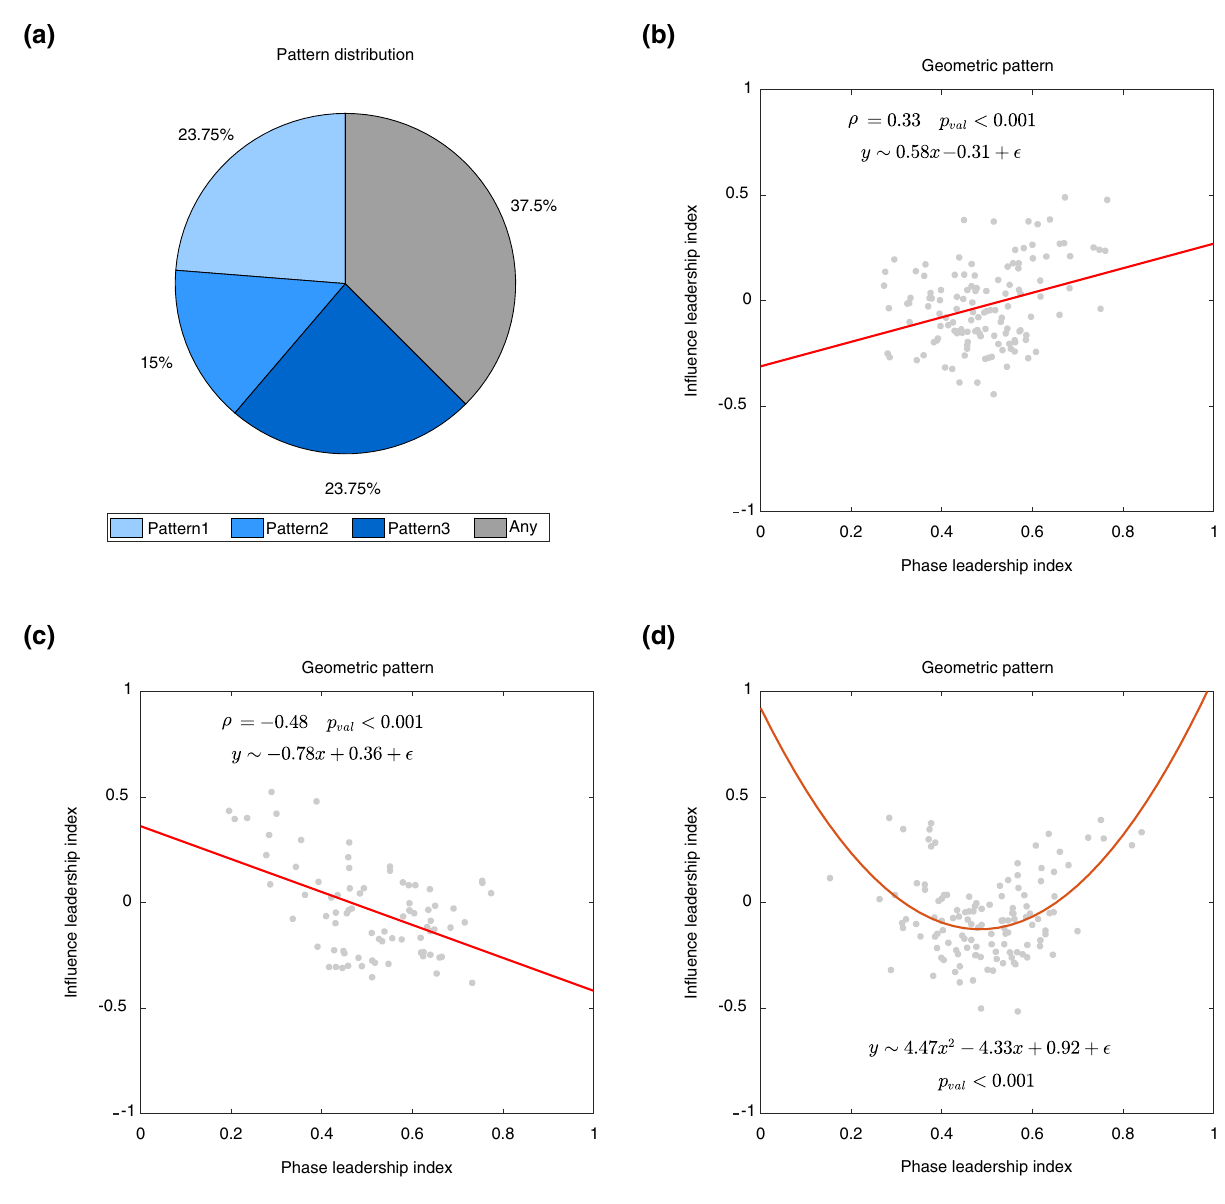
Figure 3. Distribution and characterization of the leadership scenarios. ( a ) The pie chart depicts how the three patterns were distributed among the trials of Experiment 1. A correlation analysis between the net information flow NetCaus and the mean position ranking H in the trials where Pattern 1 and 2 were observed is reported in ( b ) and ( c ), respectively. The linear fitting is represented by a red solid line. In Pattern 3, the relationship between NetCaus and H is instead captured by a parabolic curve fitting, which is the red solid line in ( d